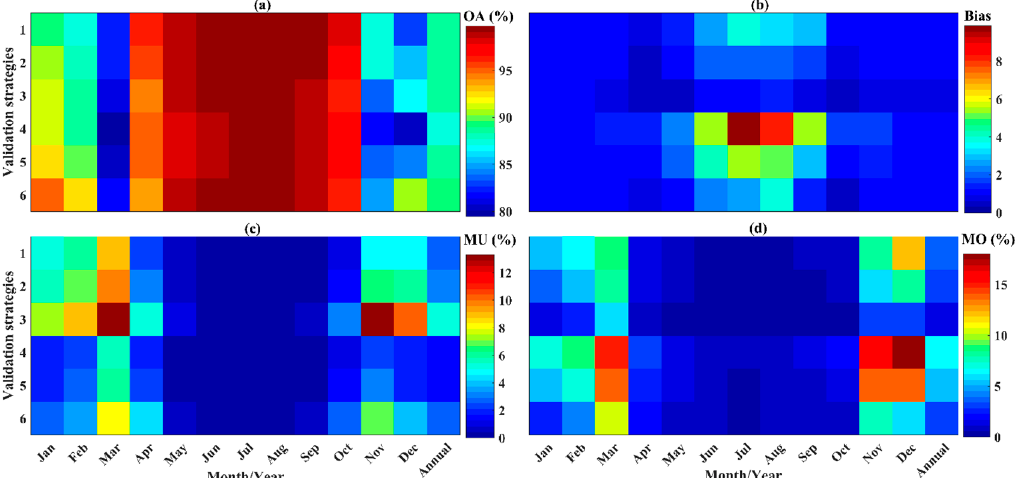
Figure 14. Monthly/annual variation of four validation indices based on different SD threshold values ( ε 1 ) and SCF threshold value ( ε 2 ). Validation strategies 1–6 represent threshold value combinations of ε 1 = 4 and ε 2 = 50%, ε 1 = 3 and ε 2 = 50%, ε 1 = 1 and ε 2 = 50%, ε 1 = 4 and ε 2 = 15%, ε 1 = 3 and ε 2 = 15%, and ε 1 = 4 and ε 2 = 15%,